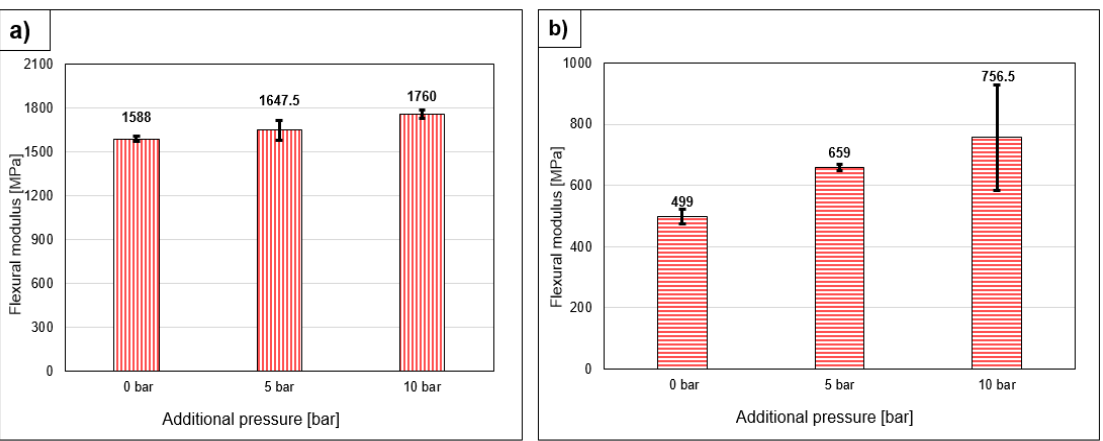
Figure 6. Flexural modulus comparison of samples printed in different pressure conditions ( a ) lon- gitudinal and ( b ) transverse to the printing direction.